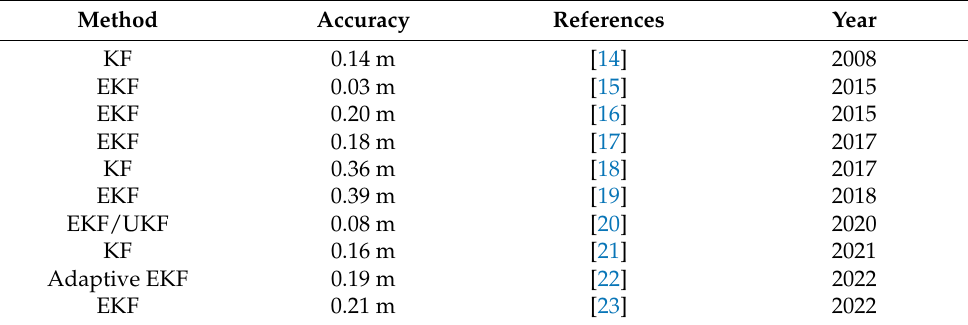
Table 1. Comparison of prior works using UWB and IMU